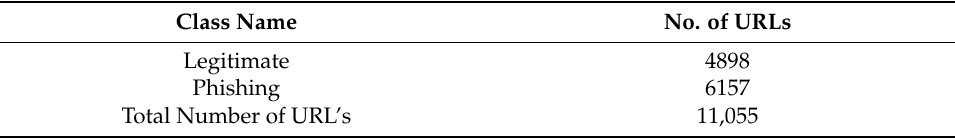
Table 1. Dataset